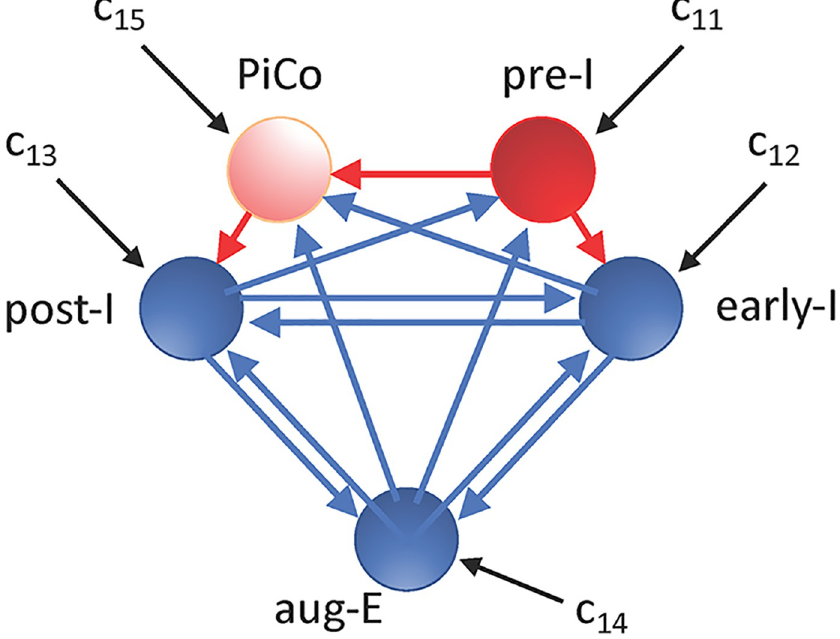
Fig 1. Schematic illustration of the respiratory network configuration considered. Red is used for excitatory units and their outputs, while blue denotes inhibitory units and their outputs. Black arrows correspond to tonic drives to units in the network. The PiCo is only included in a subset of our simulations, as indicated in the